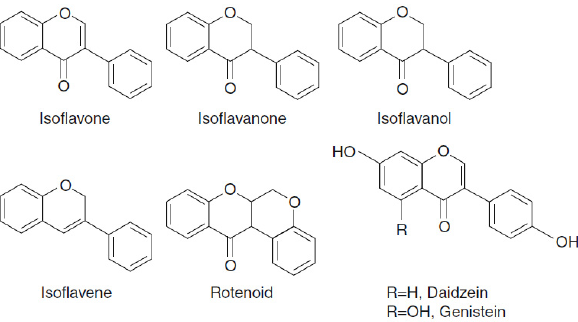
Figure 12 . Chemical structure of ( E )-2-nonenal and ( Z )-3-hexenal. Figure 6. Chemical structures of Figure 6. Chemical structures of isoflavonoids.